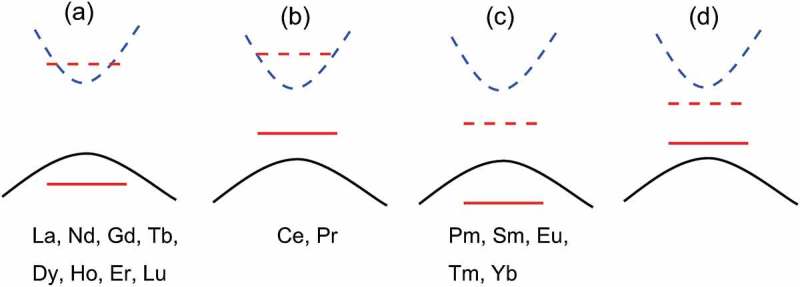
Schematic for the classification of Ln3GaO6 according to the location of occupied (red solid line) and unoccupied (red dashed line) f-level of Ln inside Eg(O 2p–Ga 4s). Black solid and blue dashed curves denote the HOMO (O 2p) and LUMO (Ga 4s), respectively. (a) The first group of Ln3GaO6 has Eg(O 2p–Ga 4s) less affected by the location of f-levels of Ln. (b) The second group of Ln3GaO6 has Eg(Ln 4f–Ga 4s). (c) The third group of Ln3GaO6 has Eg(O 2p–Ln 4f). (d) The last group of Ln3GaO6 has Eg(Ln 4f – Ln 4f), but they are not found.